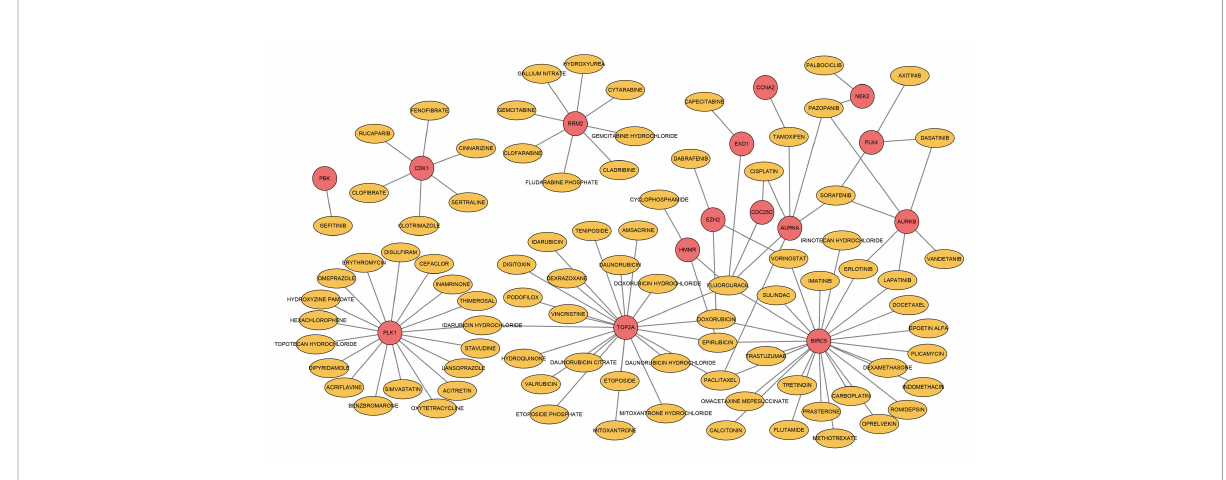
FIGURE 5 Drug – hub DEGs interplay network. Yellow circles, potential target drugs; red circles, upregulated